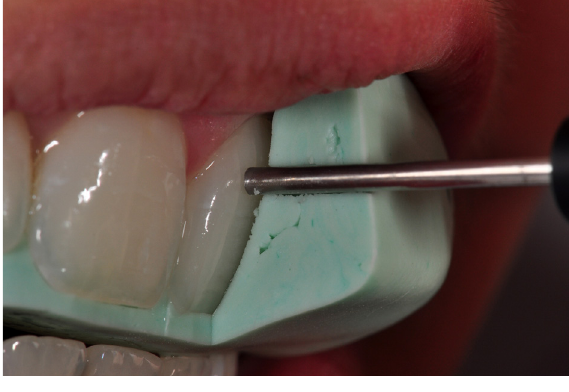
Figure 1. Transversal view of the probe tip positioned in the silicone